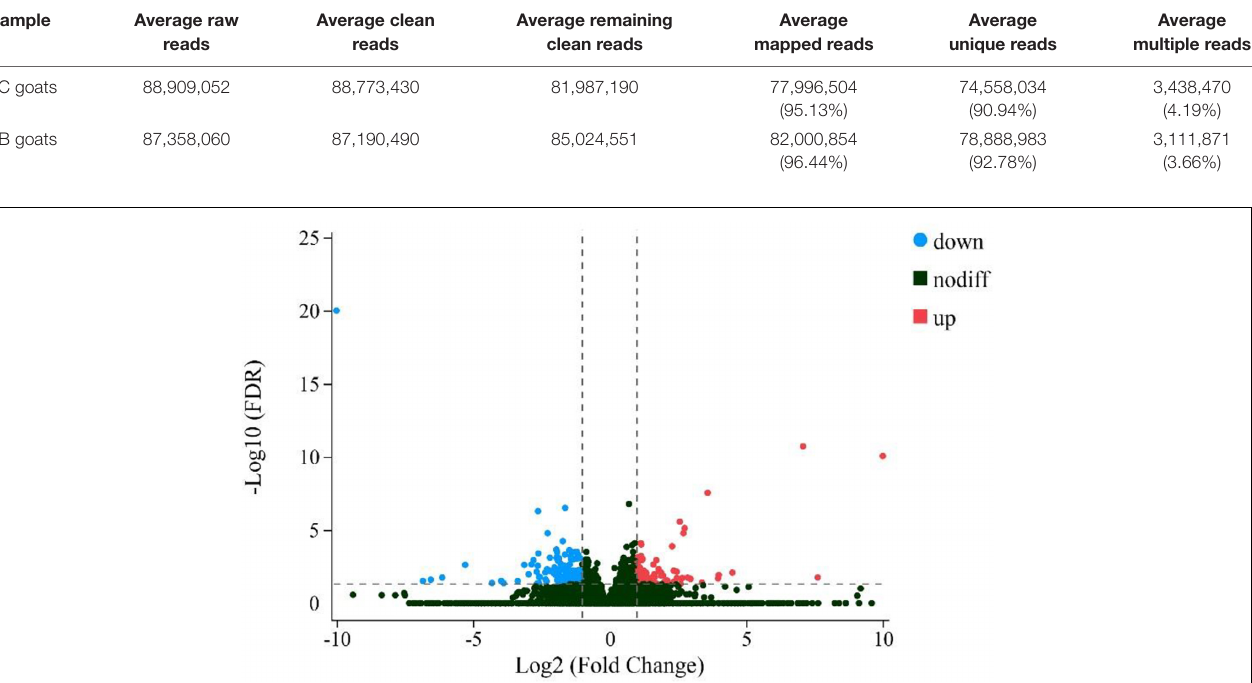
FIGURE 1 | The percentage of collagen fibers in the Longissimus dorsi muscle (%). (A) The micrographs (400 × ) of the Longissimus dorsi muscle from LC rams. (B) The micrographs (400 × ) of the Longissimus dorsi muscle from ZB rams. The collagen fibers and muscle fibers in the Longissimus dorsi muscle tissues were stained with blue and red, respectively. (C) Comparison of the percentage of collagen fibers in the Longissimus dorsi muscle tissues from LC rams, with those from ZB rams; ∗ p < 0.05. TABLE 3 | The summary of the RNA-Seq data.